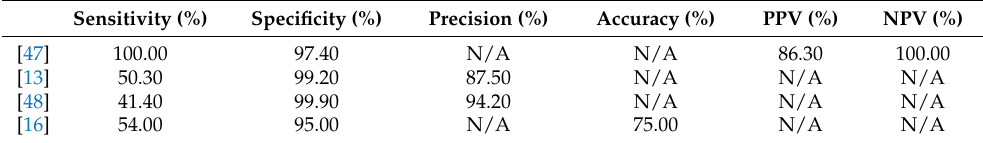
Table 5. PLF performance measures for bovine production.